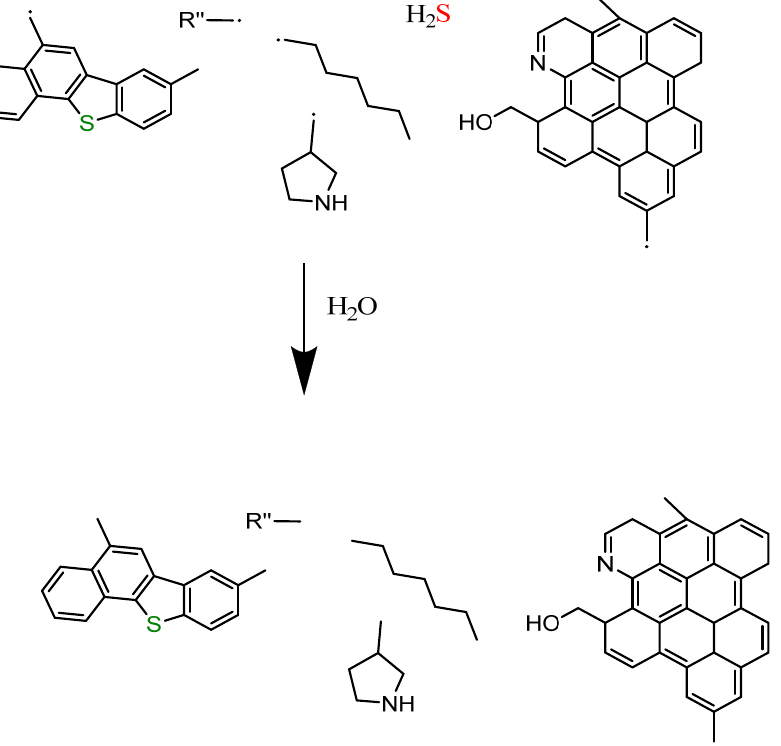
Scheme 3. Proposed mechanism of catalytic aquathermolysis of heavy crude oil components (as-